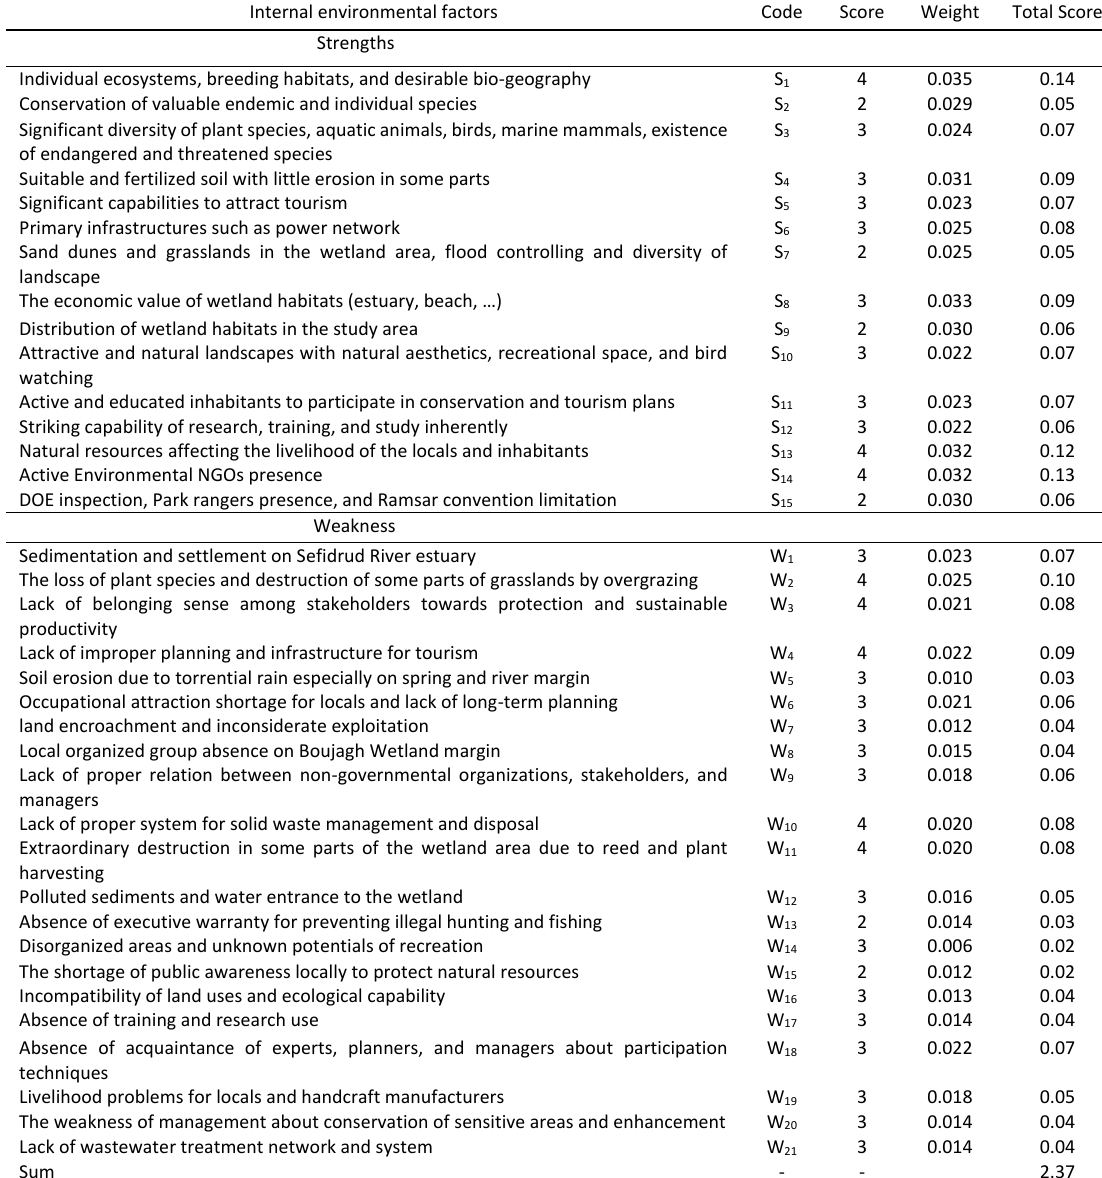
Table 2: IFEM of environmental management of Boujagh Wetland area Internal environmental factors Code Score Weight Total Score Strengths